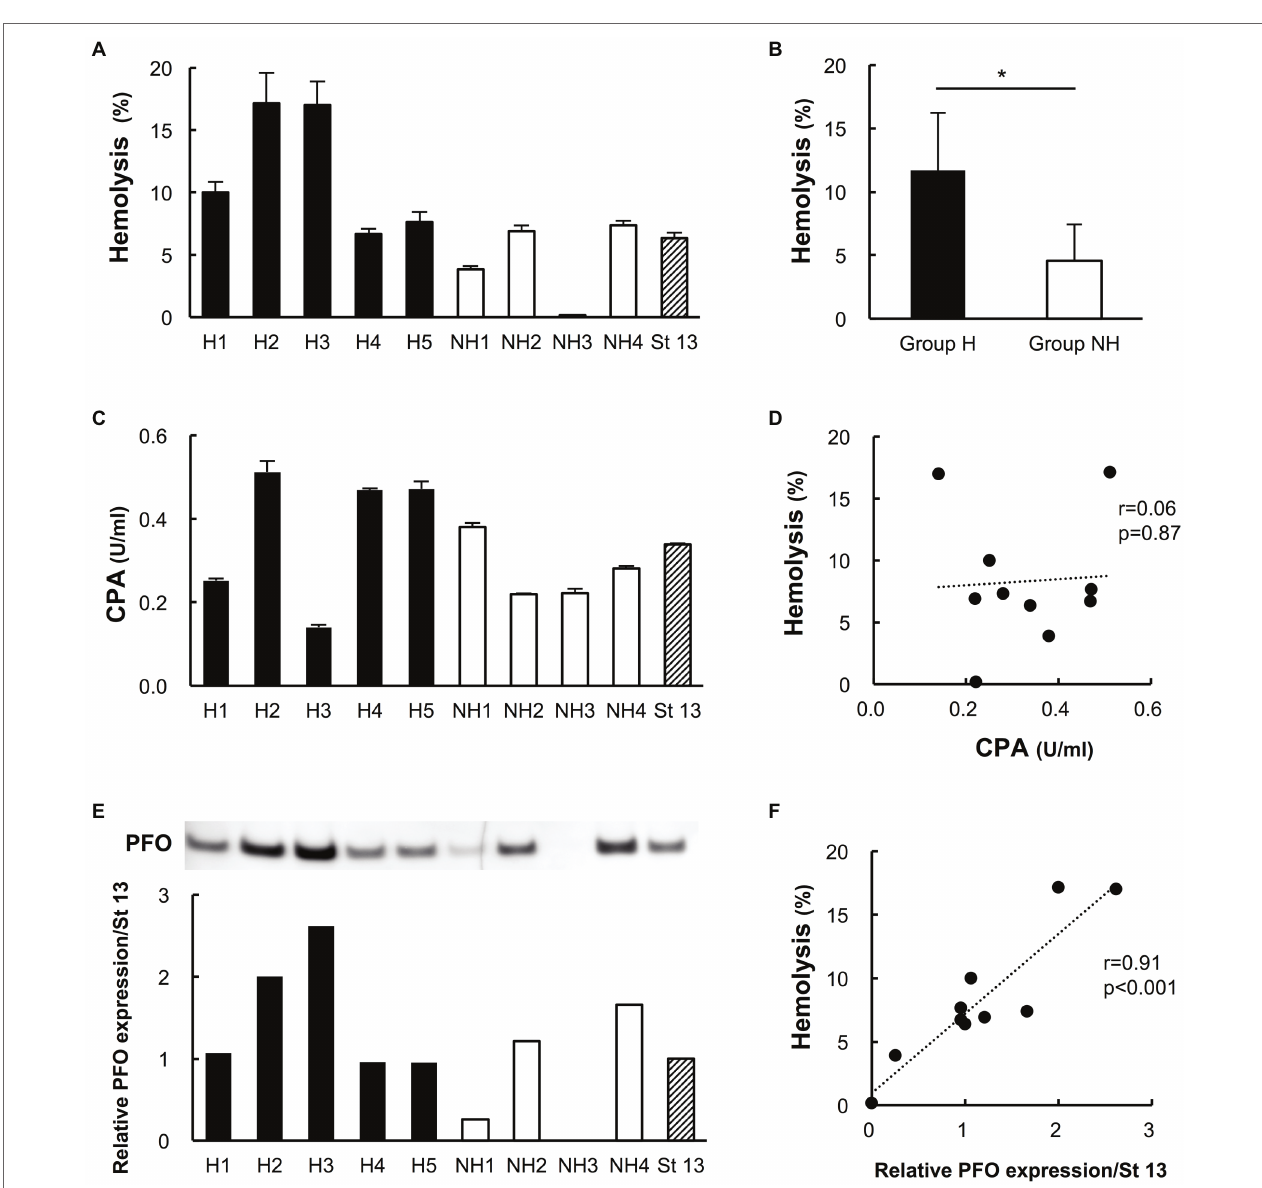
FIGURE 2 | Hemolytic effects on human erythrocytes and the production of phospholipase C (CPA) and perfringolysin O (PFO) in culture supernatants of clinical isolates. Five strains in group H and four strains in group NH, except for the two slow-growing strains (NH5 and NH6), were studied. Strain 13 (St 13), a standard strain, was also examined for comparison. (A) Hemolytic effect of culture supernatants of clinical isolates on a 40% human erythrocyte suspension. The hemolysis rate of each strain was calculated according to a formula. The solid bars show strains in group H, the open bars show strains in group NH, and the diagonal striped bar shows strain 13. The values are the average of three independent experiments conducted with technical triplicates, and the error bars indicate the SDs. (B) Hemolytic effect of group H ( n = 5) and group NH ( n = 4) strains on a 40% human erythrocyte suspension. * p < 0.05 (C) CPA concentration in culture supernatants of clinical isolates. The values are the average of three independent experiments conducted with technical duplicates, and the error bars indicate the SDs. (D) Correlation between the hemolysis rate and CPA production. The hemolysis rate is plotted against the CPA concentration. (E) Expression of PFO in culture supernatants of clinical isolates, as determined by Western blot analysis. Relative PFO expression normalized to that of strain 13 is expressed numerically. (F) Correlation between the hemolysis rate and PFO production. The hemolysis rate is plotted against the relative PFO expression level normalized to that of strain